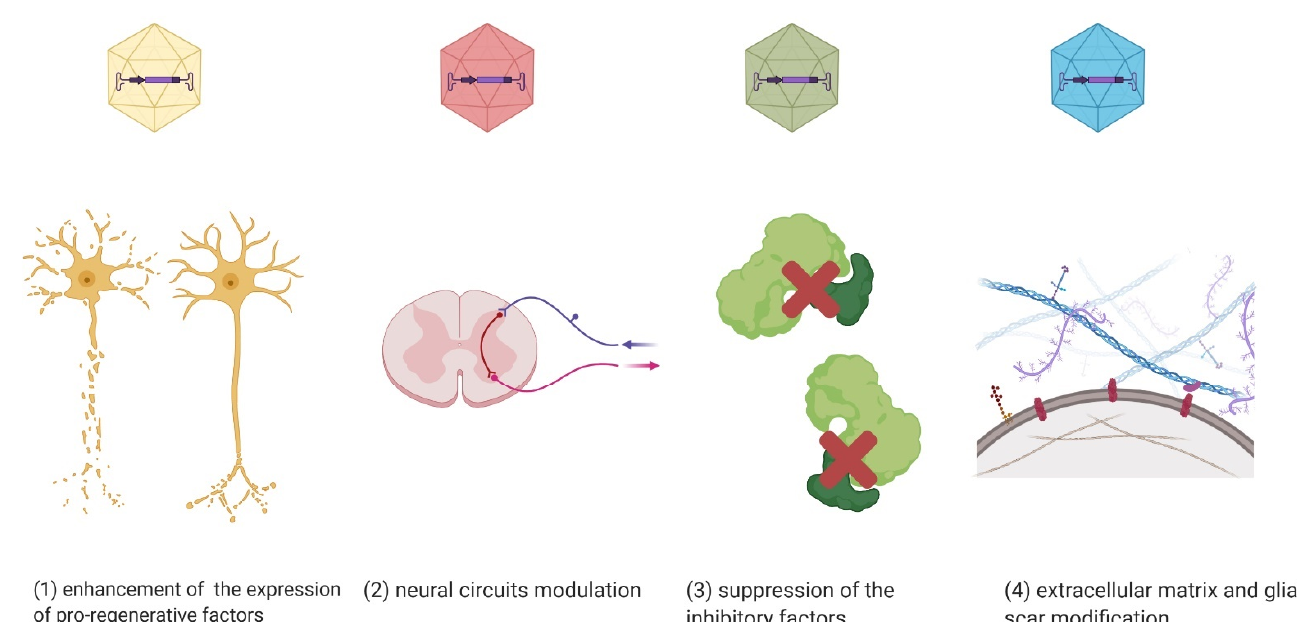
Figure 2. Gene therapy applications shown in preclinical SCI models. AAV vectors can express ( 1 ) pro-regenerative factors, ( 2 ) circuit-modifying factors, ( 3 ) repressors for inhibitory factors, and ( 4 ) matrix/glial scar-modifying factors (Created with